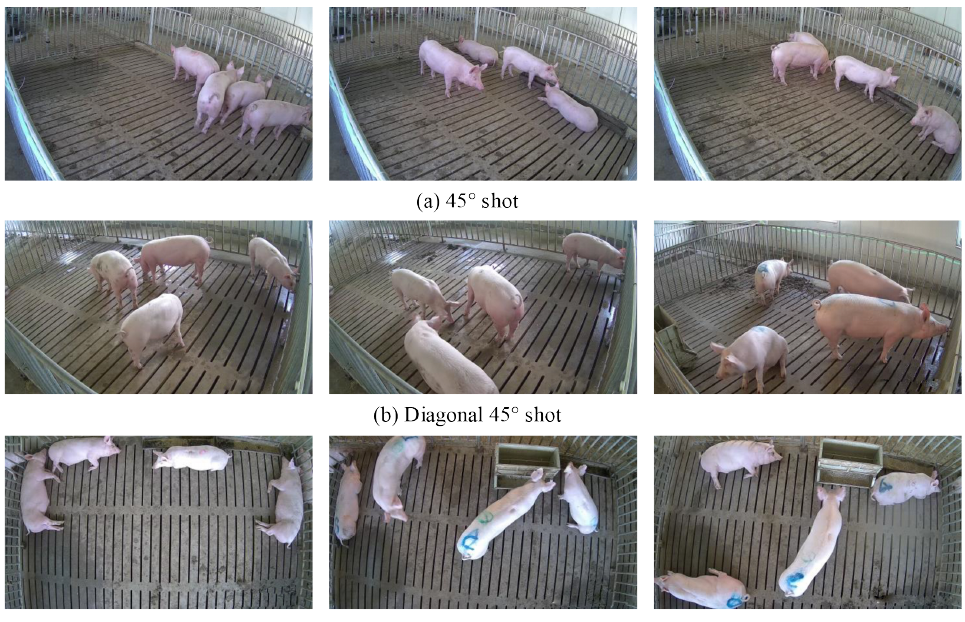
Figure 1. Some examples of the dataset.